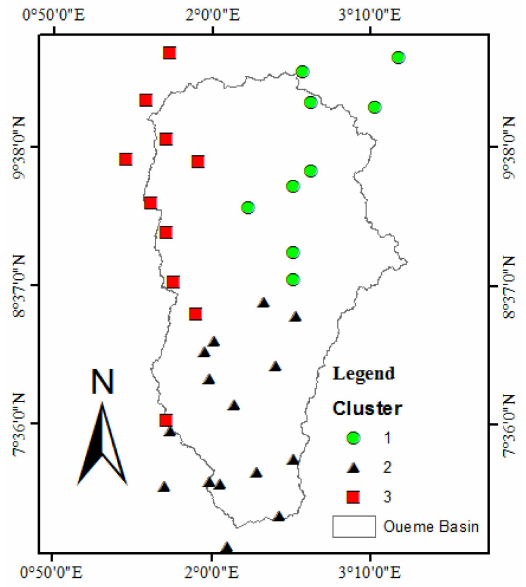
Figure 2. Location of rainfall sites of the three groups (clusters) in the Ouémé